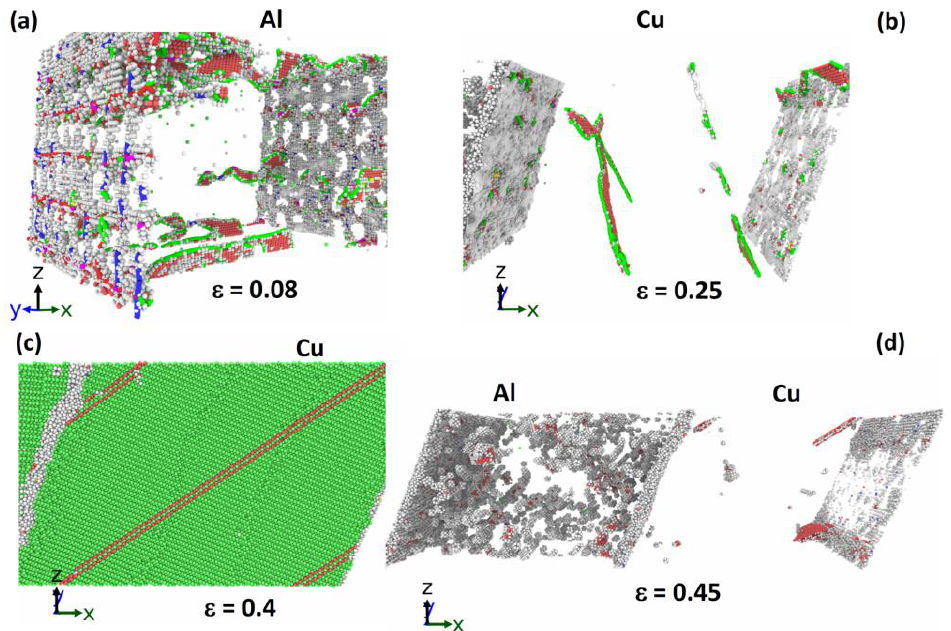
Figure 17. Development of plastic deformation in Al-Cu composite with the (110) interface at the initial pressure of 0 GPa: ( a ) plasticity initiation in Al; ( b ) penetration of plasticity into Cu part; ( c ) twin layer in Cu; ( d ) disappearance of stacking faults in Cu. The corresponding values of engineering strain 𝜀 are indicated in the figure.